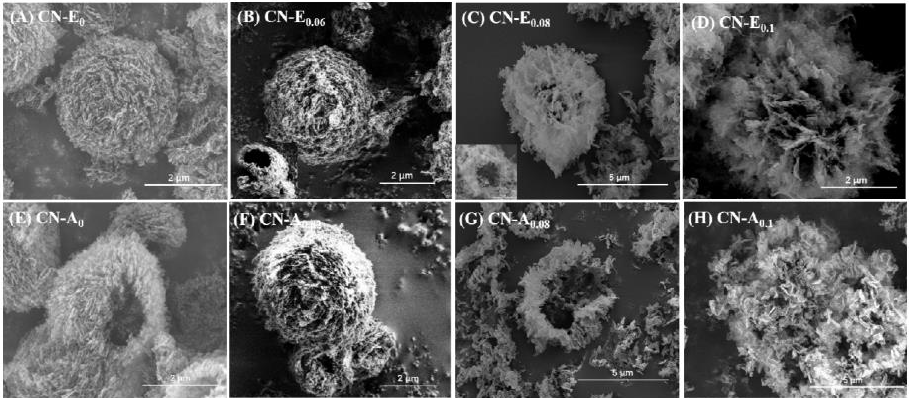
Figure 6. SEM images of hollow mesoporous carbon nitride spheres with different content of ionic liquid. Reprinted with permission from Ref. [35]. Copyright 2018 Elsevier.